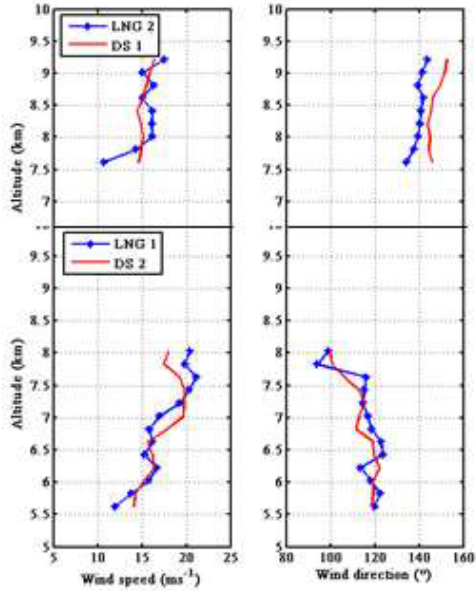
Fig. 4: Vertical profiles of wind speed and direction retrieved from VADs 1 and 3. Note that VAD 3 is closer in time and space to the dropsonde